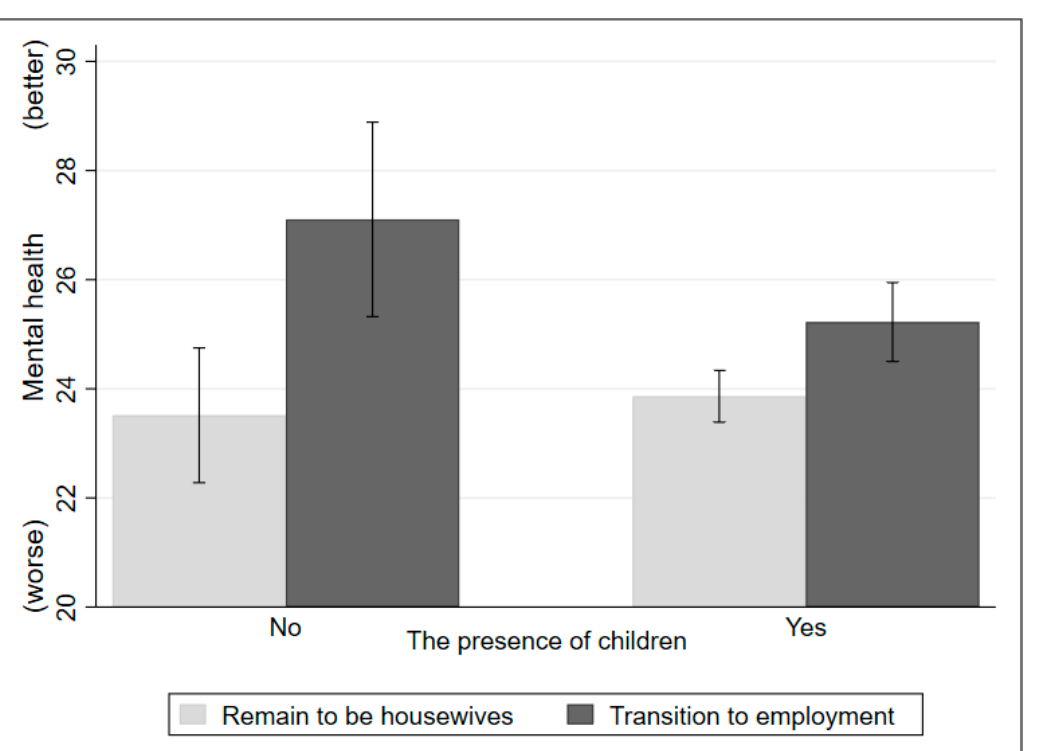
Figure 3. The moderation effects of the presence of children in the impacts of job status transition (separate samples of the traditional and egalitarian groups).